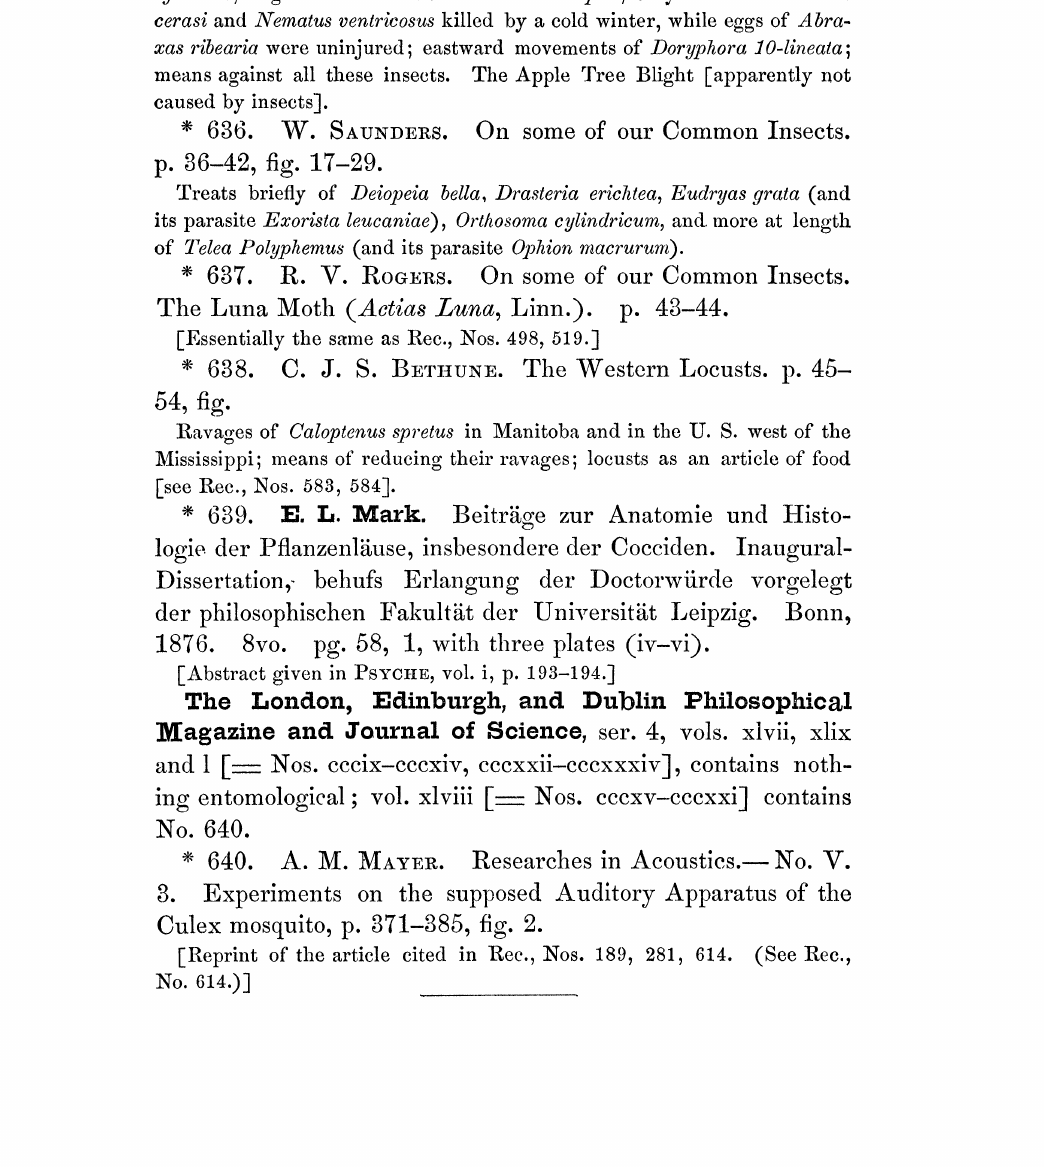
fig. 1-6. Summary of what is known reap. Anisopteryx vernata and A. pometaria; means against them; ntural enemies. [A. vernata appears in spring only; A. Tometaria in both full and spring. B.P.M.] Scarcity of insects generally; hbits of Clisiocampa americana and C. sylvatica; migrations and habits of Pieris rapae; chrysalids of Selandria cerasi and Nematus ventricosus killed by u cold winter while eggs of A bra- xas ribearia were uninjured; eastward movements of Doryphora lO-lineata; means against all these insects. The Apple Tree Blight [_apparently not caused by